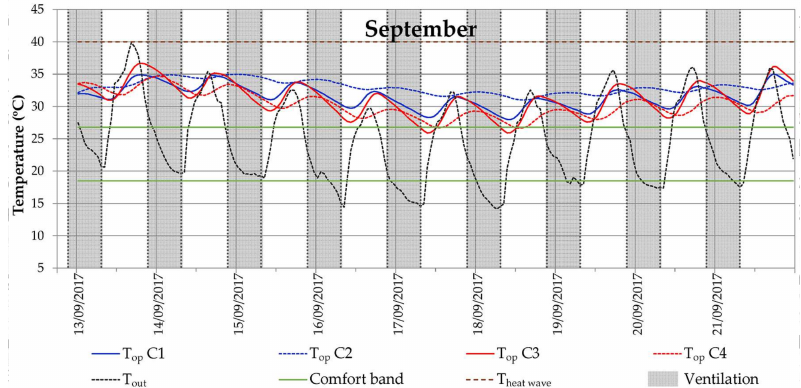
Figure 9. September protocol (night-time ventilation, from 22:00 to 8:00): Daily evolution of operative temperatures in each cell compared to outdoor temperatures (see Supplementary Materials Figure S1e).